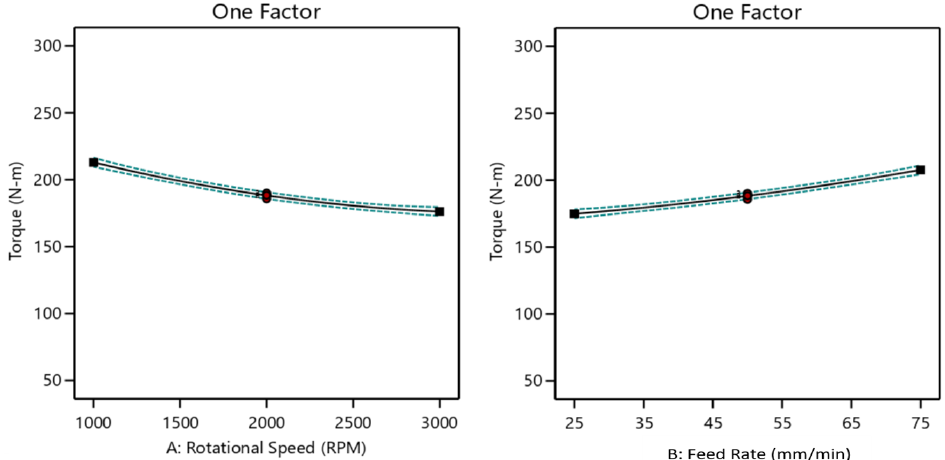
Figure 11. Effect of rotational speed and feed rate on